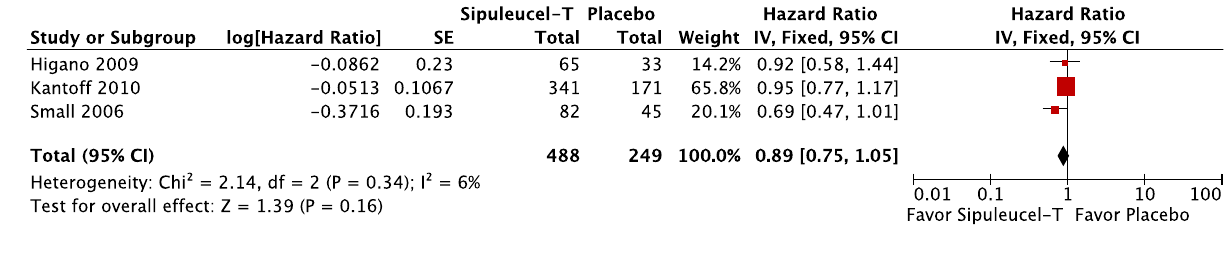
Figure 3 - Comparative effect in time to progression of Sipuleucel-T versus Placebo.